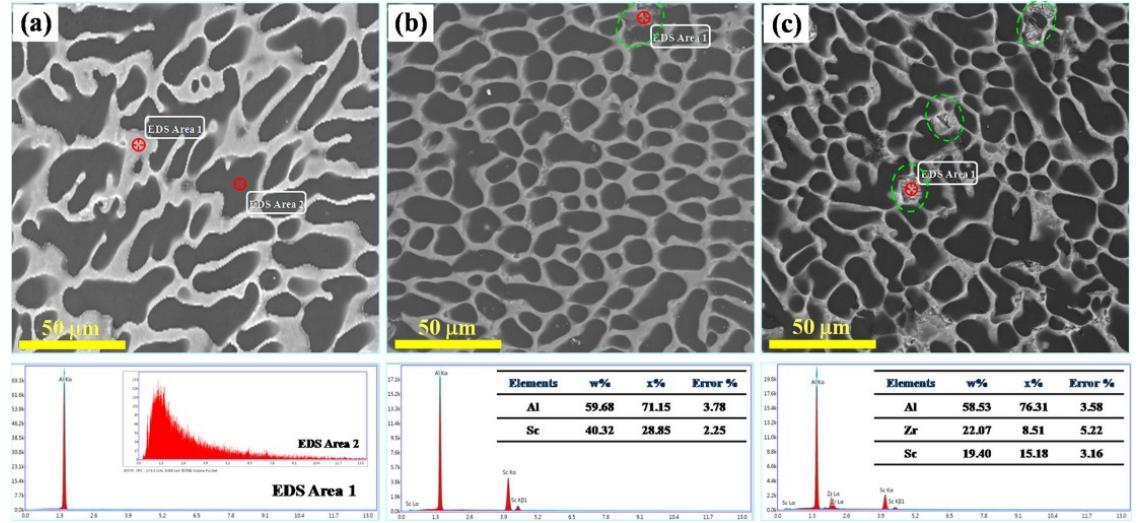
Figure 8. SEM micrographs of as-cast ( a ) Be–Al, ( b ) Be–Al–Sc, and ( c ) Be–Al–Sc–Zr alloys with corresponding area-scanning EDS profiles of marked highly faceted phases [45]. Reprinted/adapted with permission from Ref. [45]. Copyright 2018, Taylor & Francis Ltd.